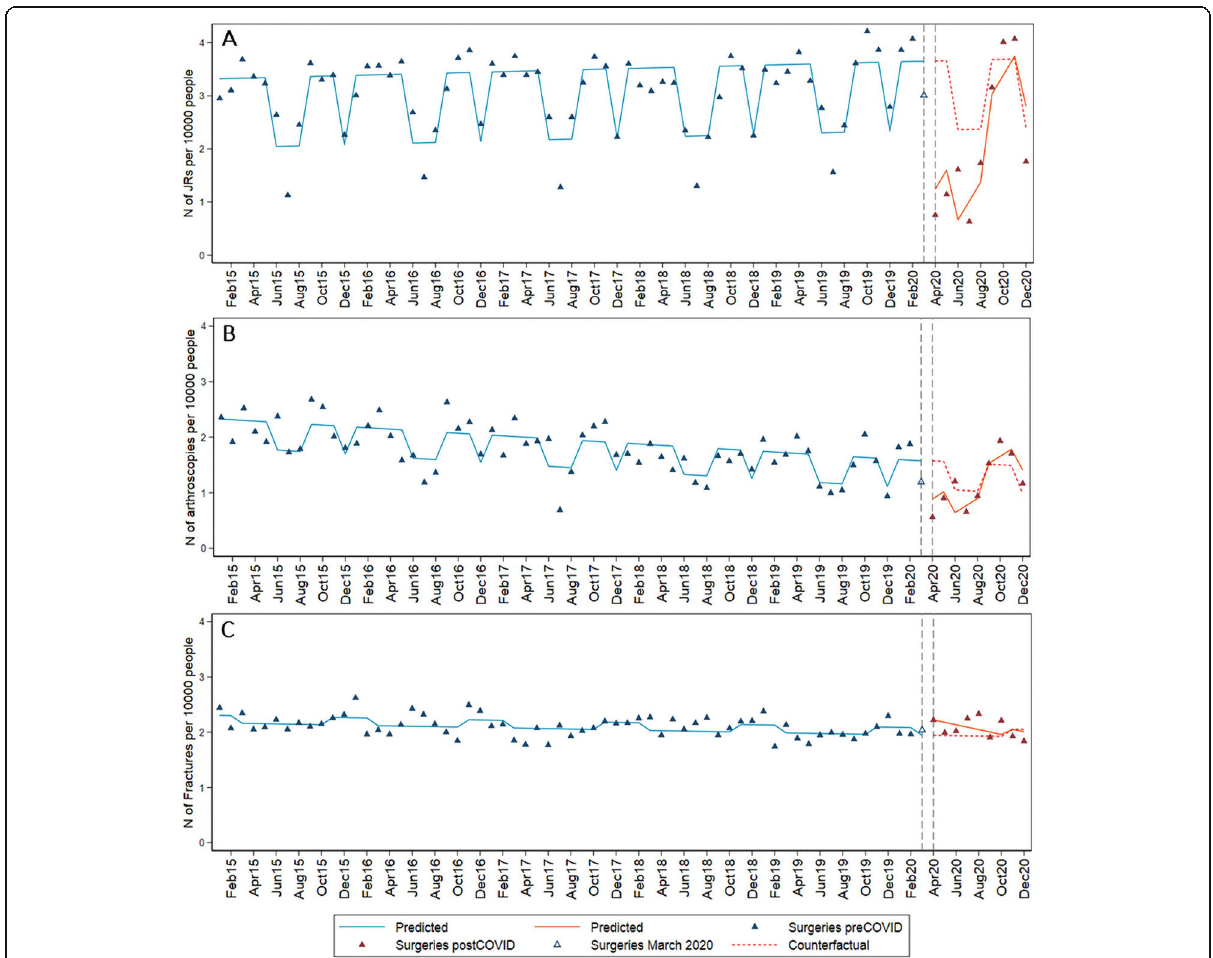
Fig. 2 Monthly incidence of surgeries per 10,000 Skåne inhabitants aged >18. a Interrupted time series for JR, c arthroscopies, and d fracture